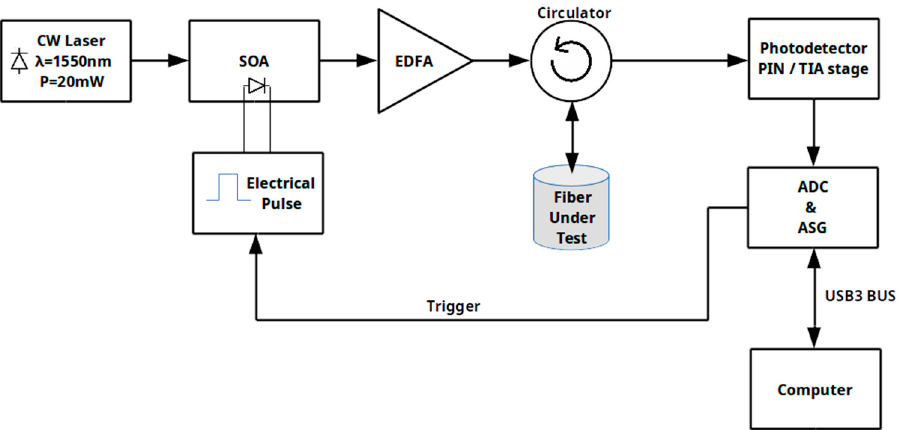
Figure 1. Schematic of the low-cost phase optical time-domain reflectometry (Phase-OTDR) system. The laser provides continuous-wave light that is pulsed by a semiconductor optical amplifier (SOA), used as a shutter. The erbium-doped fiber amplifier (EDFA) provides the final amplification to reach a peak pulse power of ~400 mW. The circulator directs the backscattered signal from the fiber under test to the detection unit, which is then converted to a voltage by the trans-impedance amplifier (TIA). The analog to digital converter (ADC) digitalizes the analog signal of each trace and sends it to the computer through the USB3 Bus. The ADC has an arbitrary signal generator (ASG) that works as an arbitrary trigger for the electrical pulse generator of the SOA.